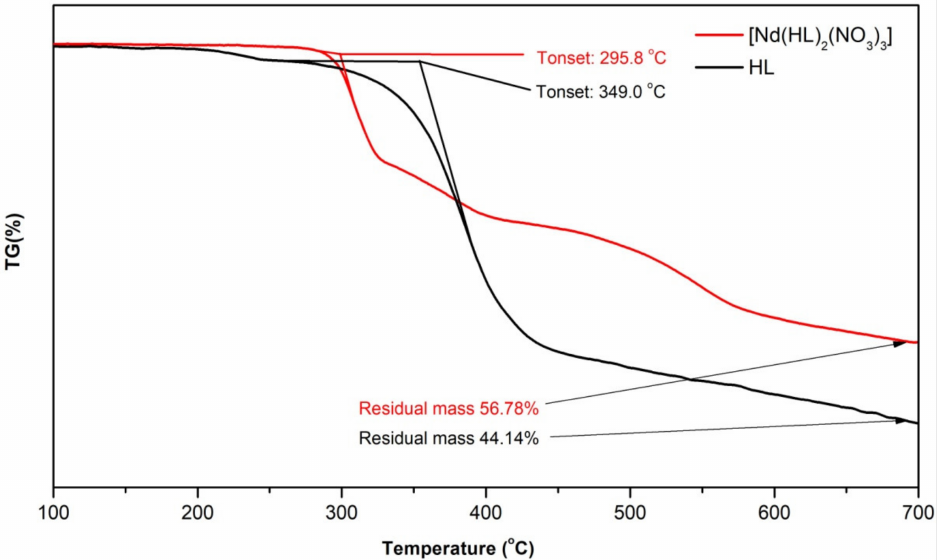
Figure 3. Thermogravimetric analysis of the synthesized [Nd(HL) 2 (NO 3 ) 3 ] and ligand HL (Tonset is established as the point of intersection of the starting-mass baseline and the tangent to the TGA curve at the point of maximum gradient).